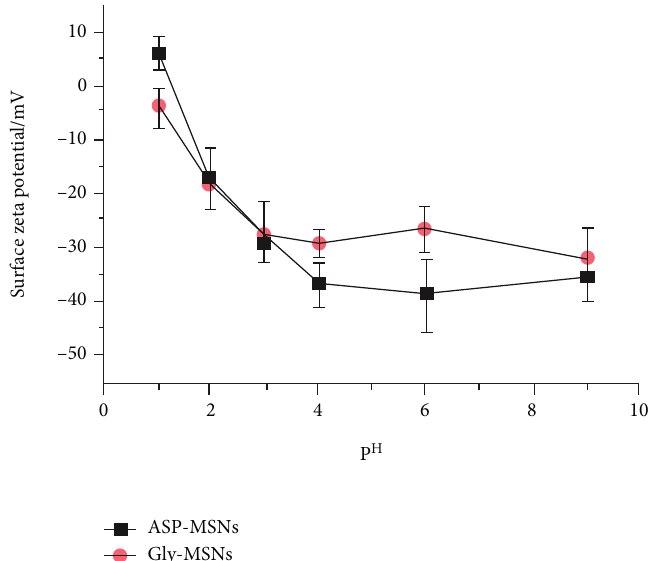
Figure 5: The electronic charges on the surface of Asp-MSNs and Gly-MSNs in aqueous solutions at di ff erent pH